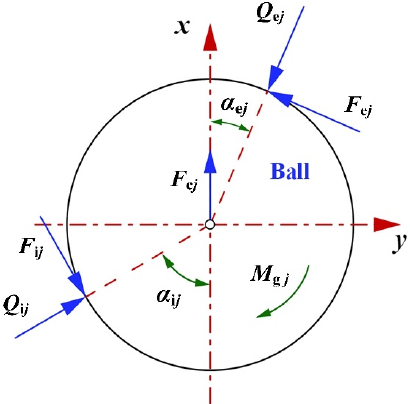
Figure 4. Forces on the ball element.